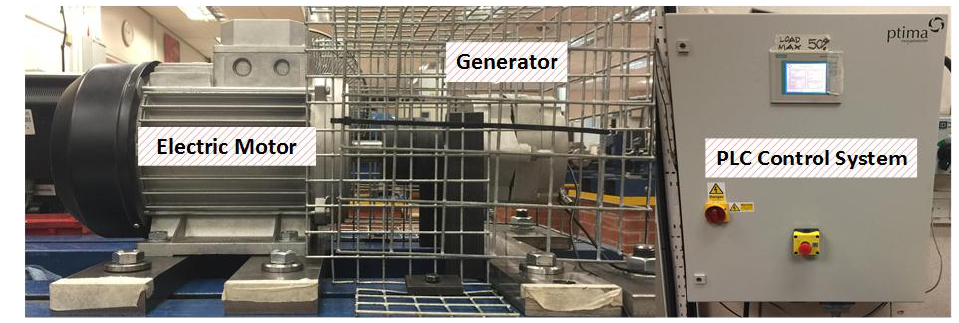
Figure 7. View of experimental generator test set up.